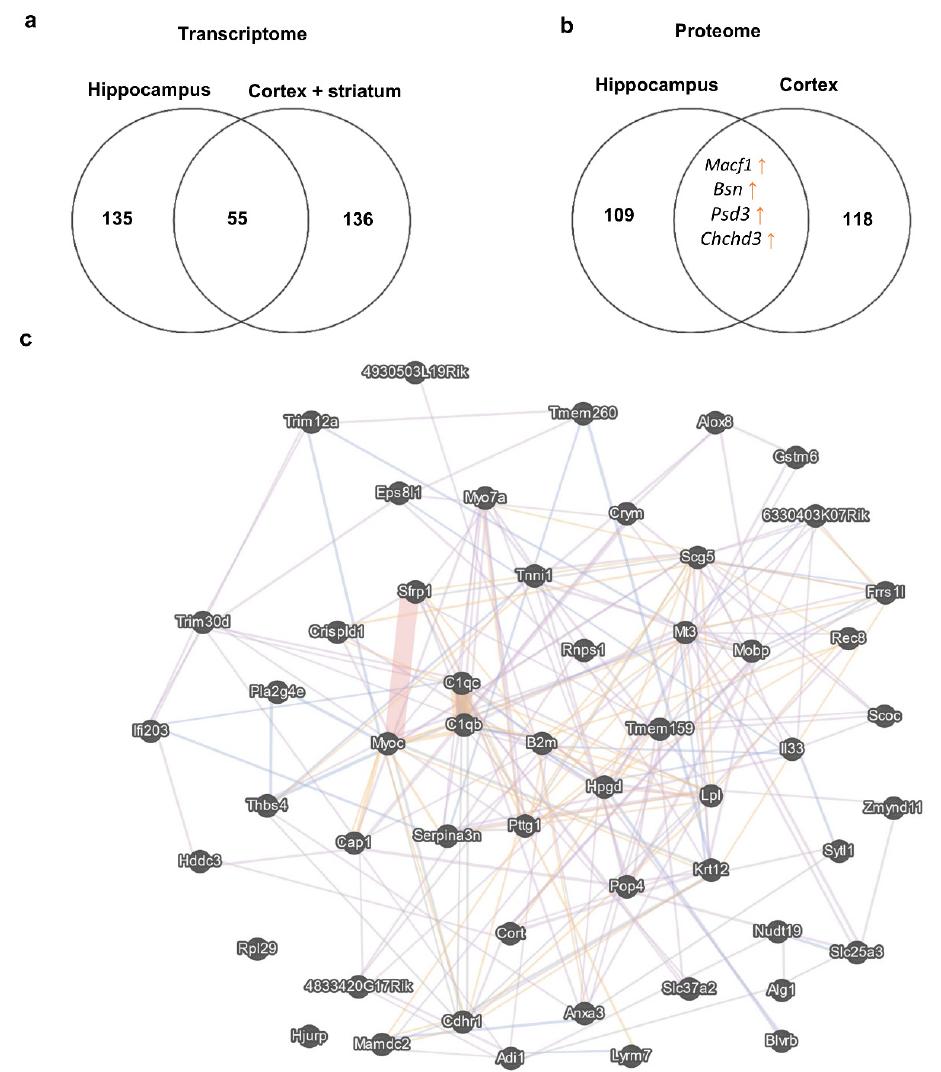
Figure 4. DEGs in the corticostriatal area and hippocampus. ( a ) This Venn diagram depicts the overlap between sets of reproducible corticostriatal and hippocampal genes changing their expression unidirectionally between these brain regions. Numbers on the diagram represent how many genes are unique for the dataset and how many overlap. ( b ) This Venn diagram illustrates the overlap between sets of cortical and hippocampal proteins changing their expression unidirectionally between these brain regions. Numbers on the diagram represent how many genes are unique for the dataset and how many overlap. ( c ) Gene mania network representation of the 55 reproducible corticostriatal and hippocampal genes changing their expression unidirectionally between these brain regions; each gene manifested expression changes in at least two datasets from the hippocampus and corticostriatal area.